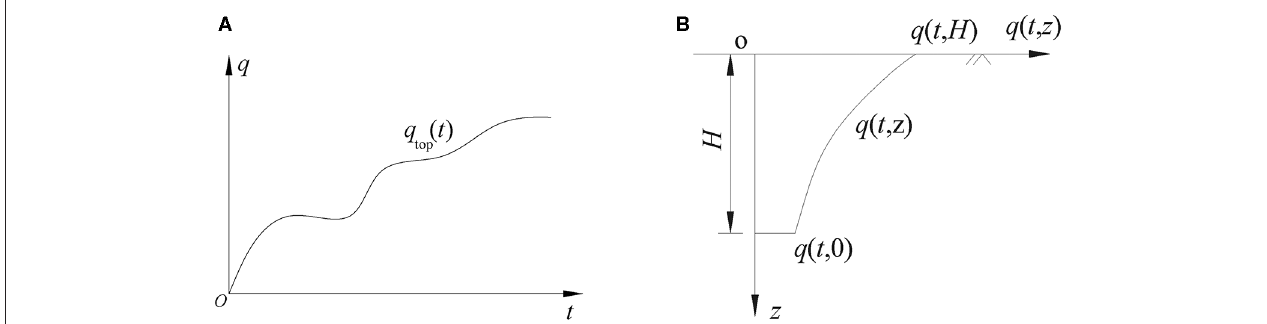
FIGURE 2 | Distribution of the additional stress in soil when the external load increases linearly. (A) External load function curve. (B) Curve of the additional stress in the compressed soil